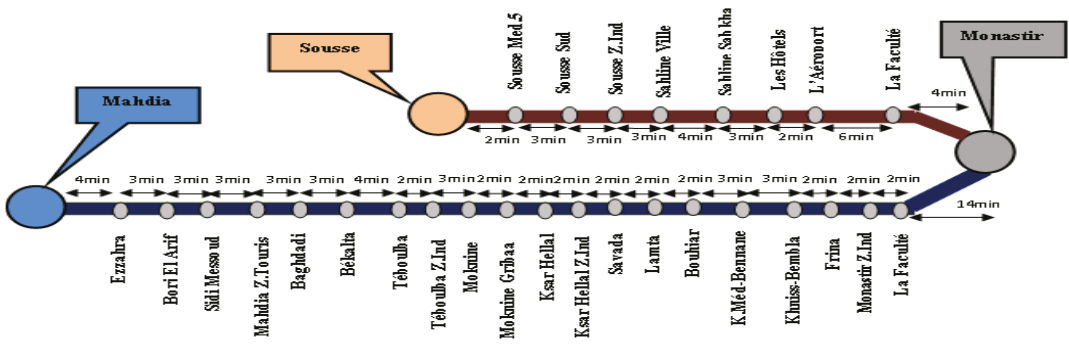
Figure 1: Sahel railway stations.